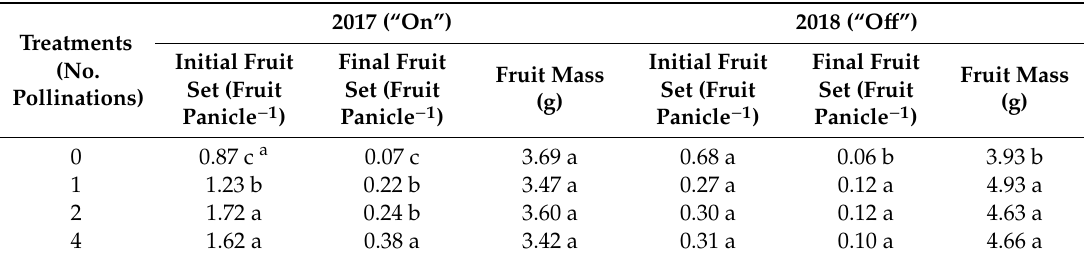
Table 1. Fruit set, size and estimated yield in monovarietal ‘Manzanillo’ olive orchards with different frequencies of artificial pollination (2017 and 2018).